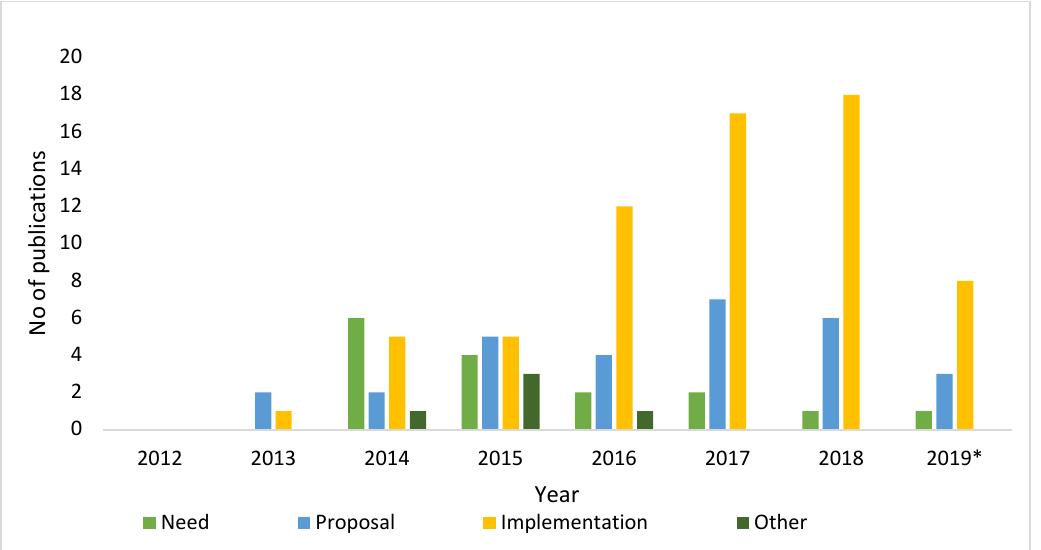
Figure 4. Distribution of different types of research work 2012-2019. *2019 data includes research published only up to July 12, 2019.